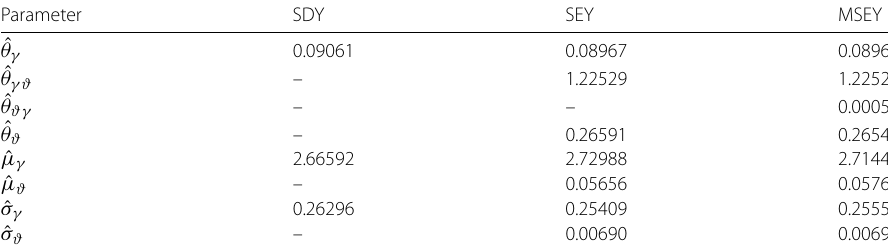
Table 1 Estimations of parameters in models SDY, SEY, and MSEY Parameter SDY SEY MSEY ˆ θ γ 0.09061